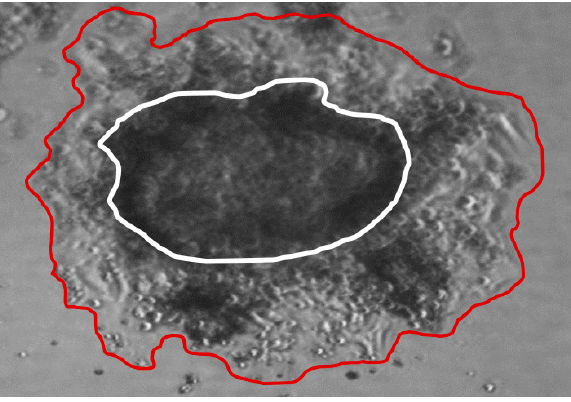
Figure 5. Light microscopic picture of a SCLC tumorosphere embedded in extracellular matrix ( ECM) showing invasive outgrowth of cancer cells. The white line indicates the contour of the original spheroid at beginning (magnification 40×).